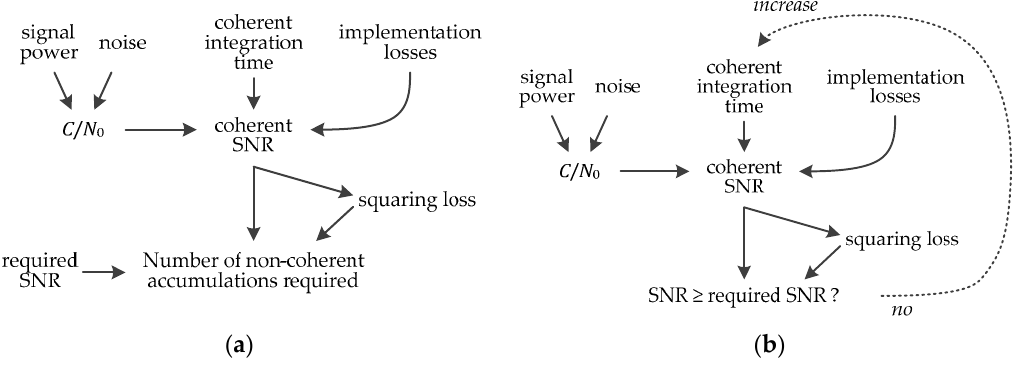
Figure 11. Evaluation of the coherent integration time and number of non-coherent accumulations: ( a ) When the coherent integration time is fixed, and the number of non-coherent accumulations is estimated; ( b ) When there is coherent integration only, and the coherent integration time is estimated.